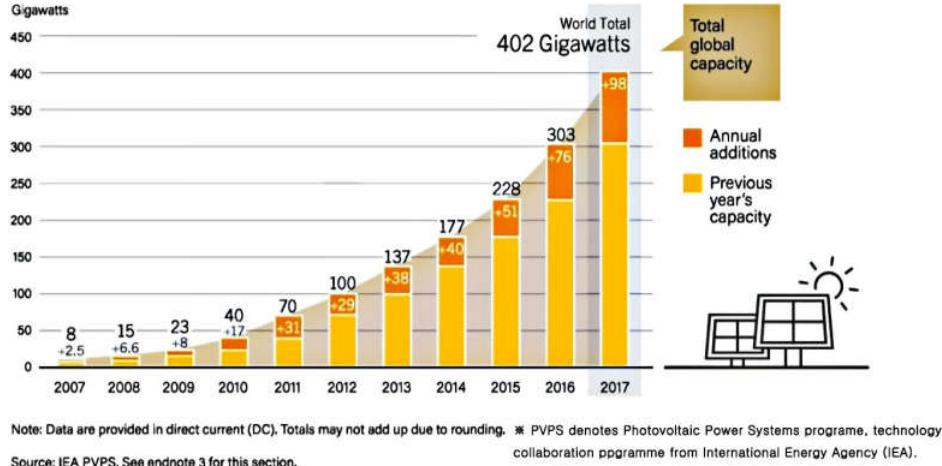
Figure 1. Global solar photovoltaic capacity and annual additions from 2007–2017.